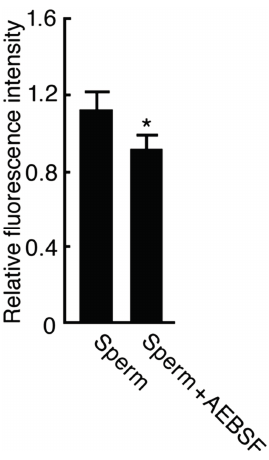
Figure 7. Detection of AEBSF-sensitive protease activity on the sperm surface. Sperm was treated with FTC-casein or co-treated with FTC-casein and AEBSF for 1 h. As the control, FTC-casein alone was incubated for 1 h, and then sperm was added. Fluorescence intensities in the sperm suspensions were measured by a fluorometer. Relative fluorescence intensities were calculated by the ratio against the fluorescence intensity in control sperm suspension including FTC-casein without being co-incubated with sperm. * p < 0.01 compared to the relative fluorescence intensity in the